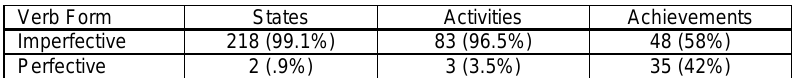
Table 5: Distribution of perfective and imperfective forms in Jenny’s speech (p < 0.001, Chi-square = 116.7 [df = 2])